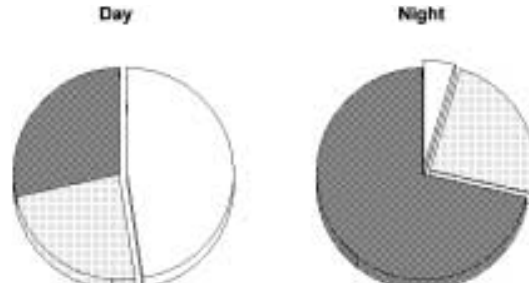
Tracing during 30 min of Cheyne-Stokes respi- ration in a patient with congestive heart failure. The tracing is part of a 24 h recording obtained in an outpatient with a novel portable monitor- ing equipment (LifeShirt ® , Vivometrics, USA). The tidal volume (VT), ribcage (RC) and ab- domen (AB) signals are measured by an induc- tance plethysmograph. The breath rate (BR) ranges from 0 to 45 breaths/min. Minute venti- lation (VI) is extrapolated from VT and BR on a breath-to-breath basis. The cycle time (CT) indicates the length of one CSR cycle that is around 60 sec in this patient. The heart rate (HR) is irregular because the patient has atrial fibrillation. The flat signal of the accelerometer (ACC) shows that the patient is resting. The pulse oximeter at the finger depicts the characteristic oscillations of the oxygen saturation (SpO 2 ) during CSR (range 97% to 84% SpO 2 ).